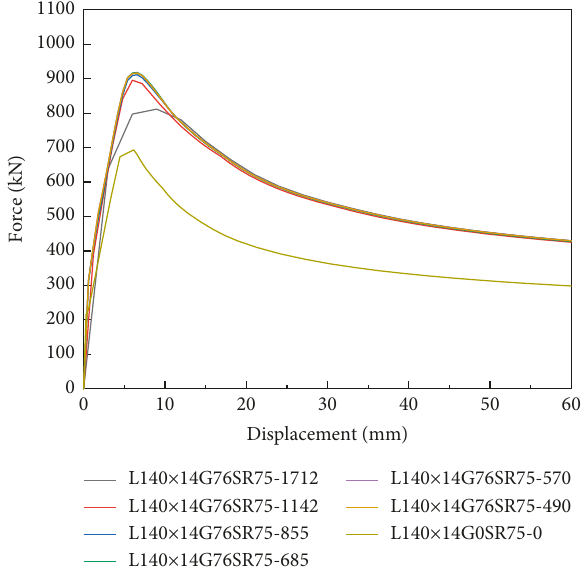
Figure 9: Force-displacement curve (L140 ×